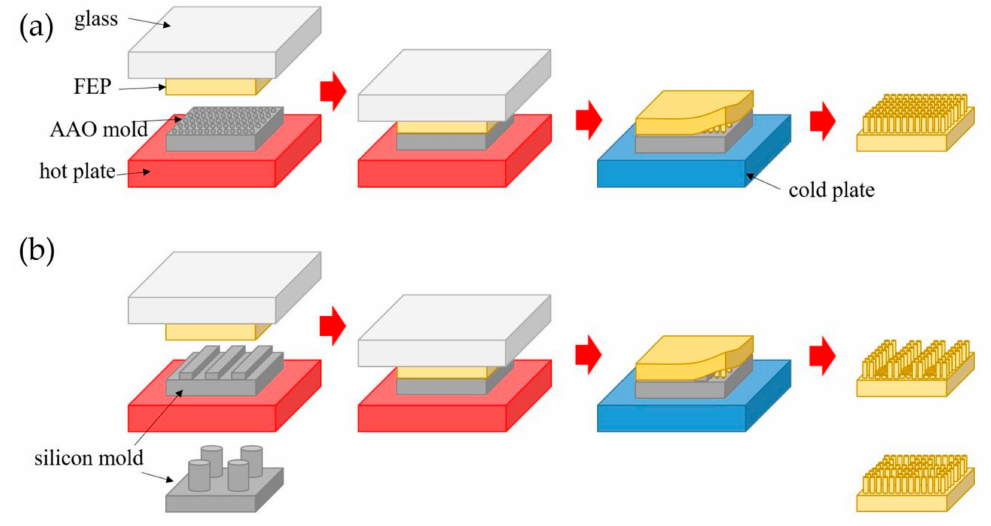
Figure 1. Schematics of hierarchical hot embossing processes. ( a ) Fabrication of nanowire structures with an AAO mold; ( b ) Fabrication of microstructures with a silicon